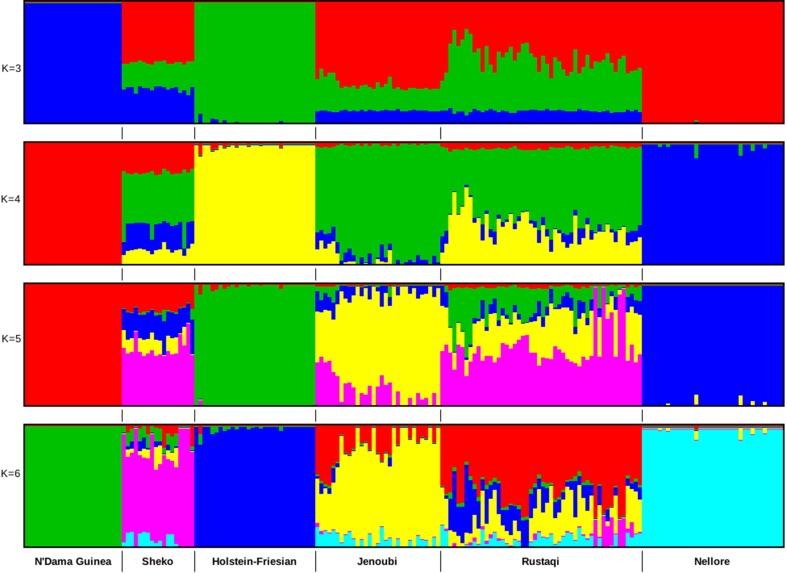
Clustering assignments of five cattle populations based on ADMIXTURE 1.3.0 (Alexander et al., 2015) for inferred K values ranging from 2 to 6. Each individual is represented by a single vertical line divided into K colored segments, where K is the number of ancestral populations.